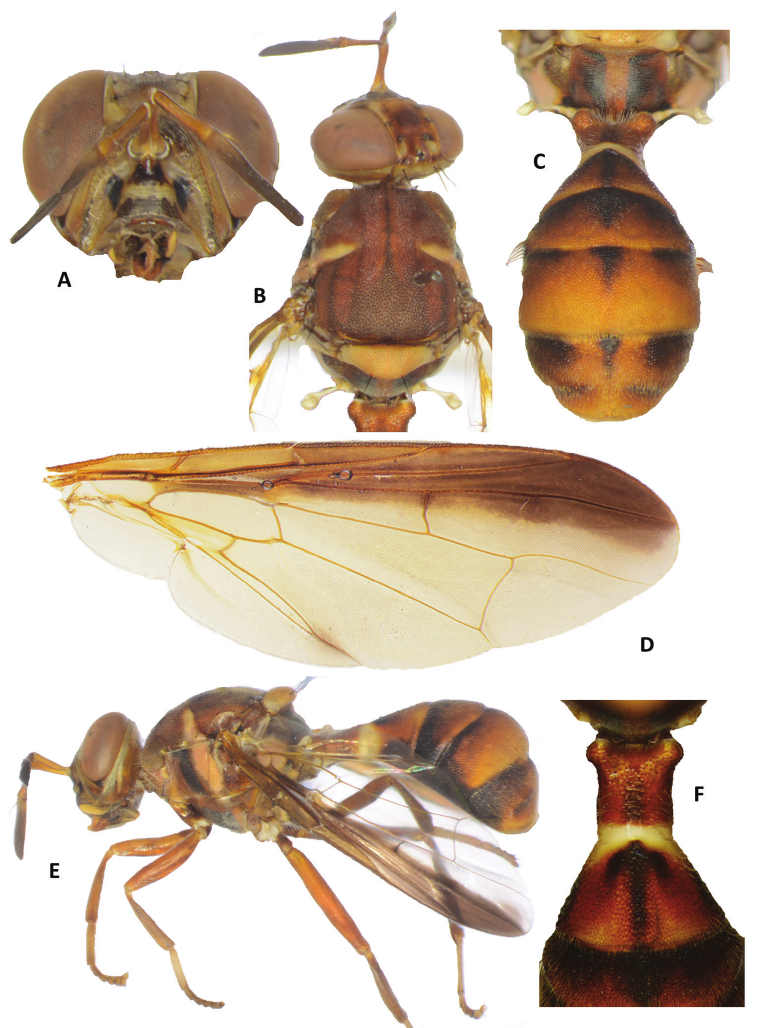
Figure 1. Dacus ( Mellesis ) ancoralis sp. n. A head B head and scutum C abdomen D wing E lateral view F Abdominal tergum II, with anchor-shaped marking.